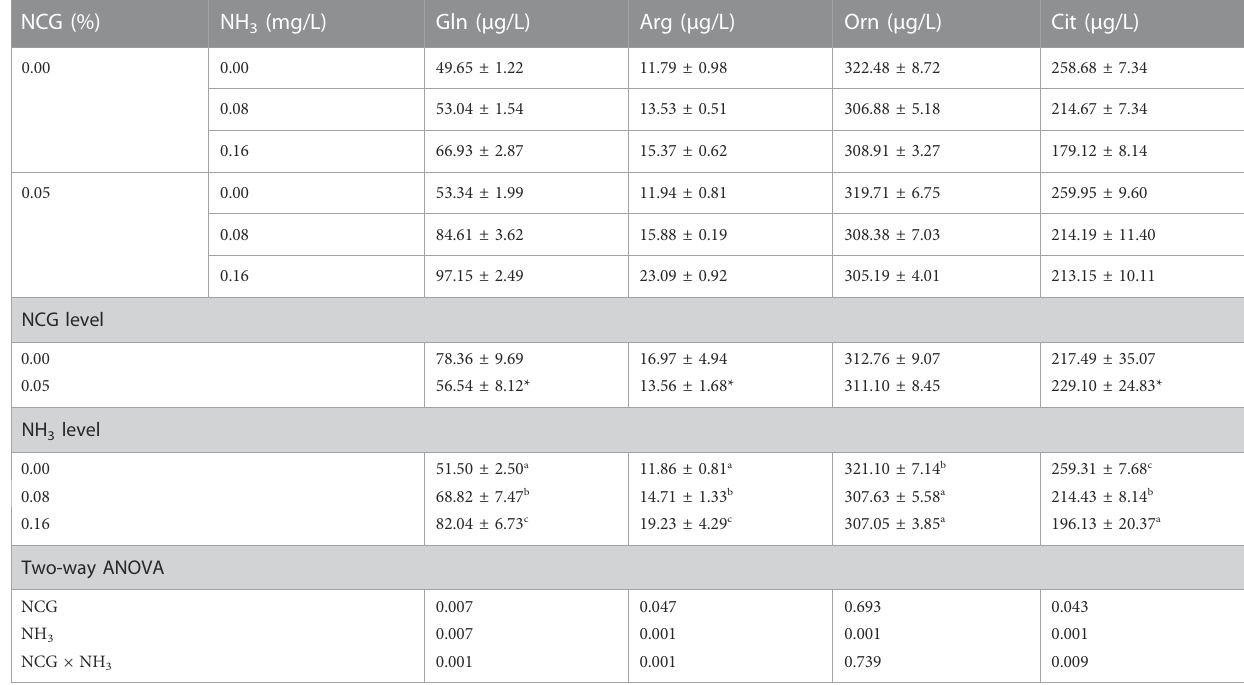
TABLE 6 Effects of dietary N -carbamylglutamate supplementation on serum free amino acid content of yellow cat fi sh exposed to different ammonia levels for 84 days.